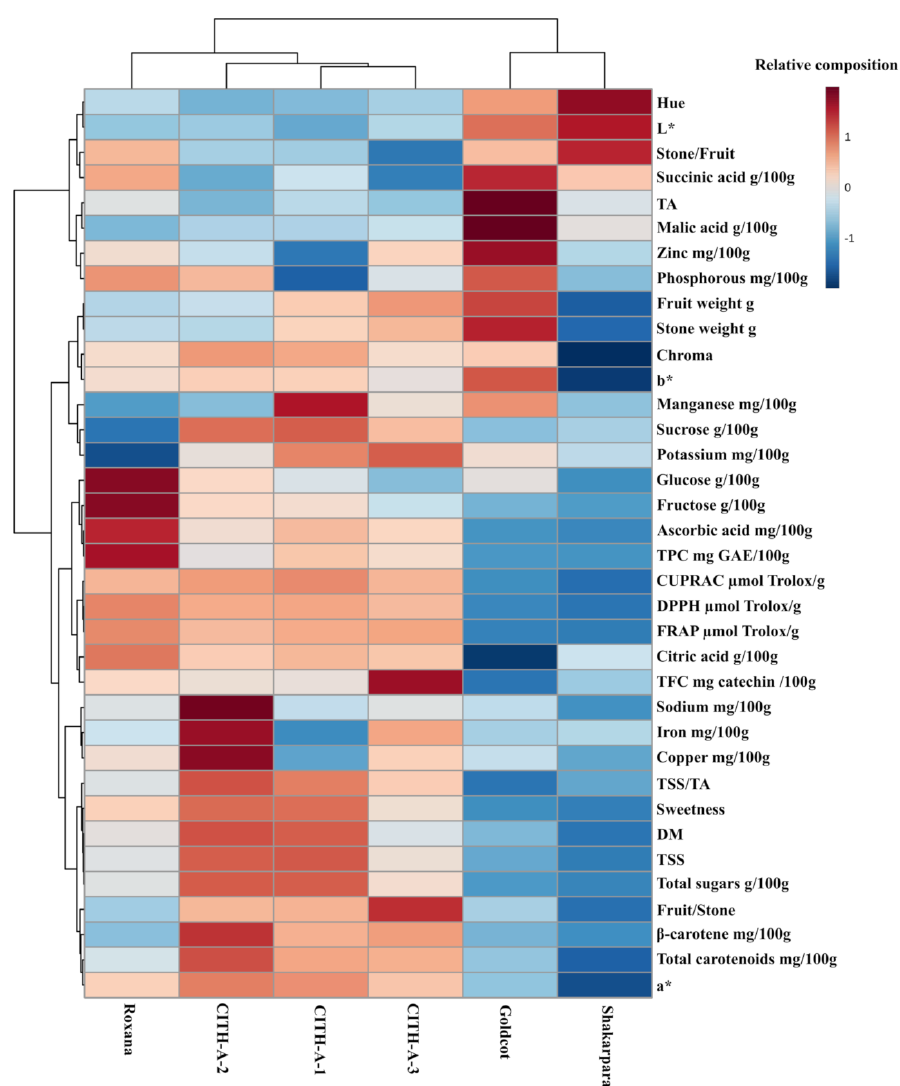
Figure 6. Heat map analysis of apricot genotypes and parameters. The genotypes and parameters are presented in ‘X’ and ‘Y’ dimensions, respectively. The blue–red colour map visualizes the relative value of the parameter for each genotype in a scale of low value (intensity of blue), to high value (intensity of red). L*—lightness; a*—redness; b*—yellowness; TA—titratable acidity; TFC—total flavonoids content; TPC—total phenolics content; DM—dry matter, TSS—total soluble solids;